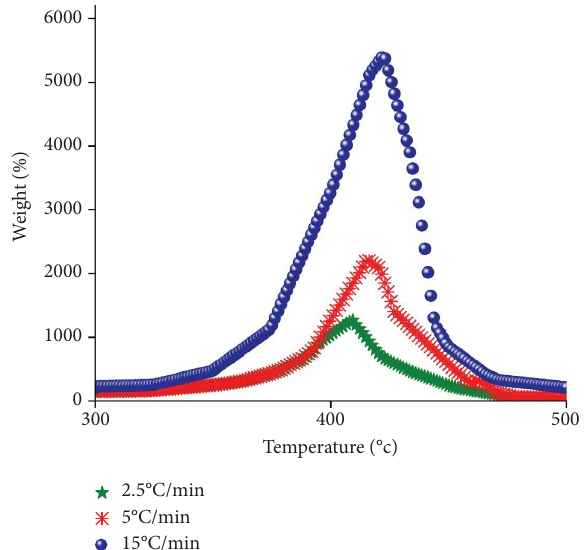
Figure 7: DTG curves of ACM-CB60-HNT6 composites at dif- ferent heating rates under nitrogen atmosphere.